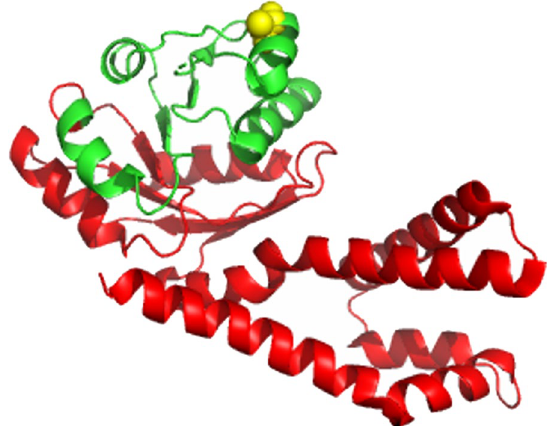
Fig. 3 Schematic description of the location of the novel pathogenic